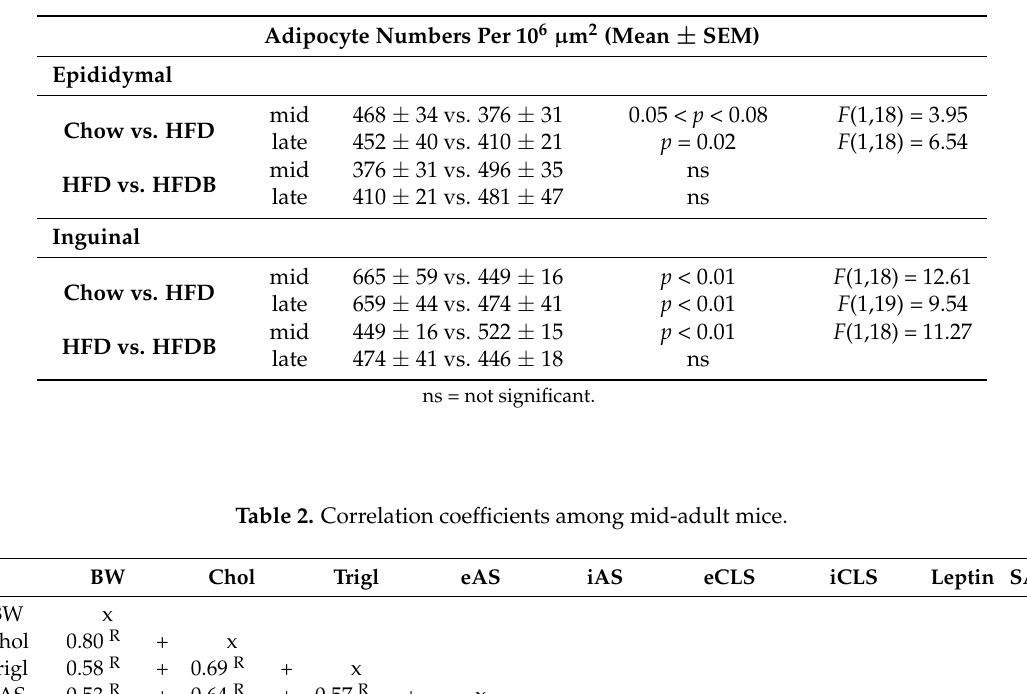
Table 1. Adipocyte numbers. Represented are the combined mean numbers of two slides.